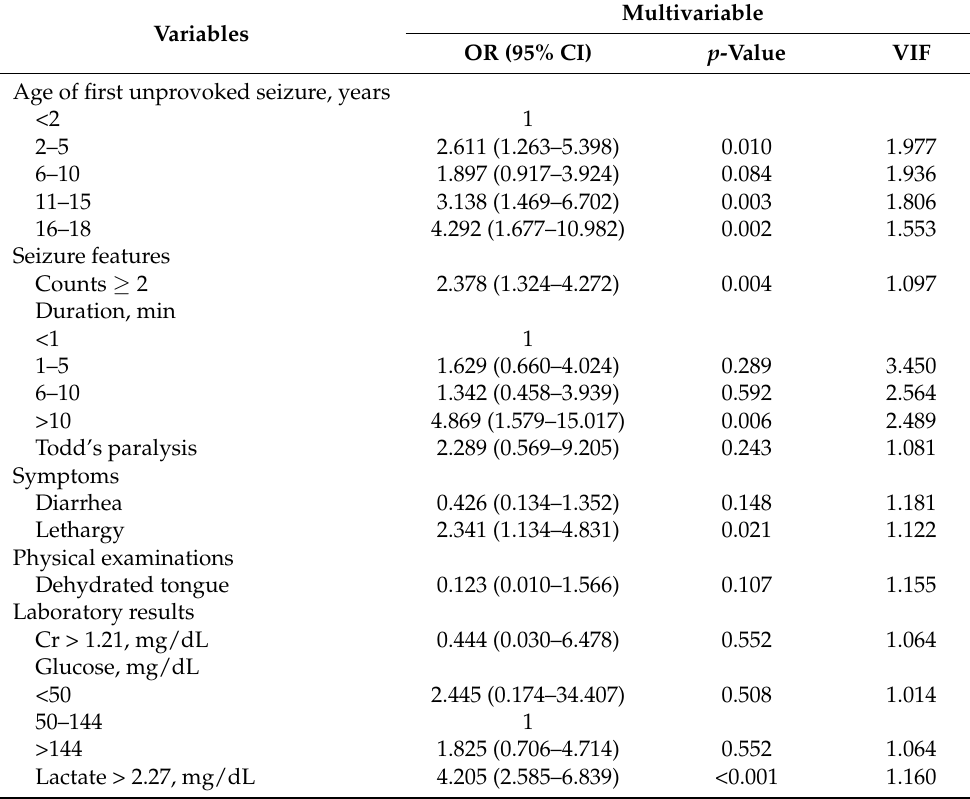
Table 2. Multivariable logistic regression analyses of risk factors for the possibility of transition to epilepsy in pediatric afebrile seizure